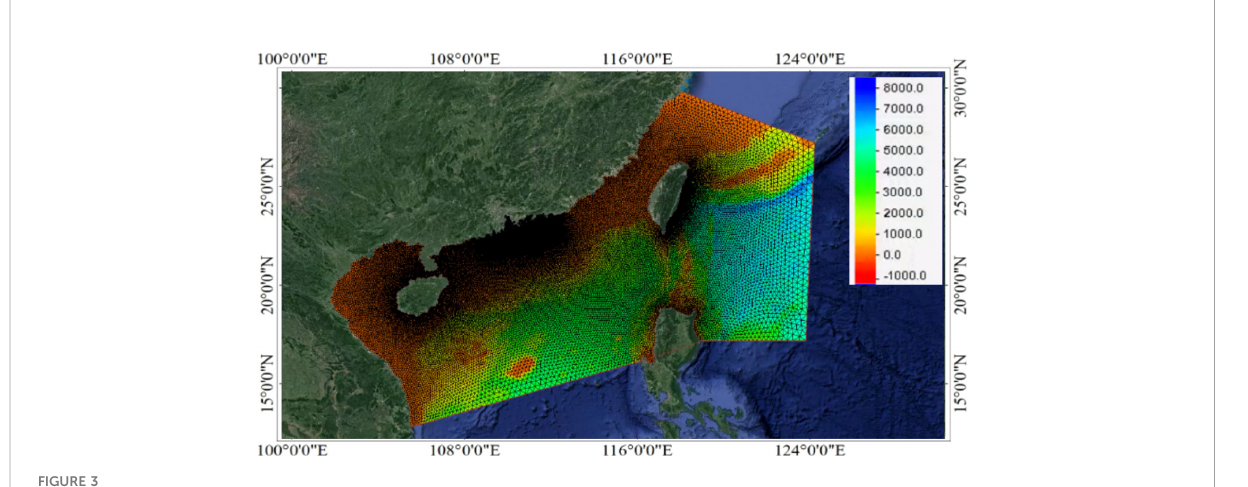
FIGURE 3 The computational domain with unstructured triangular